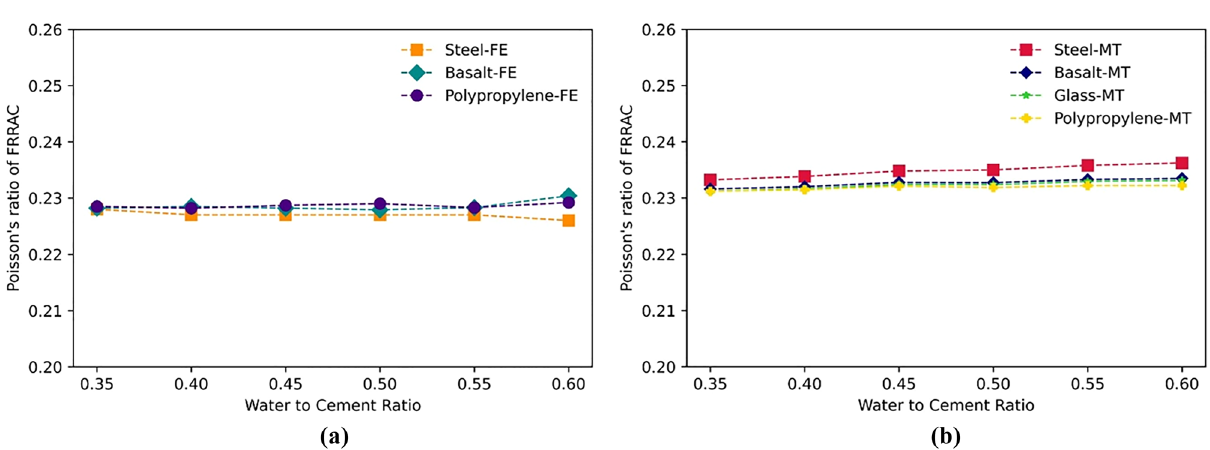
Figure 16. The Poisson’s ratio of FRRAC based on w/c ratio: ( a ) FE approach, ( b ) MT